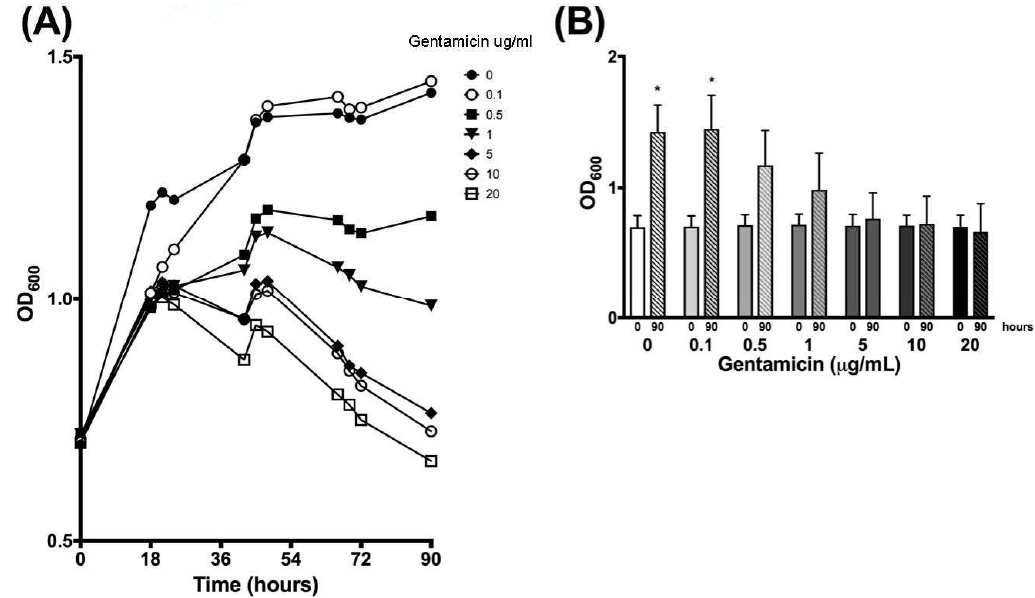
Figure 7. Optical density (OD) assay of M. avium gentamicin dose response. ( A ) OD of M. avium with gentamicin treatment over 90 h at 600 nm. Differences between the slopes of each treatment are significant at p < 0.0001 according to linear regression analysis. Average values are reported without error bars for graph clarity. ( B ) Optical density (OD) of M. avium with gentamicin treatment at time zero and 90 h. M. avium demonstrated increased OD with 0 and 0.1 µg/mL gentamicin treatment at * p < 0.05 according to two-tailed, paired T -test analysis. M. avium treated with higher doses of gentamicin were not significant, n = 3.